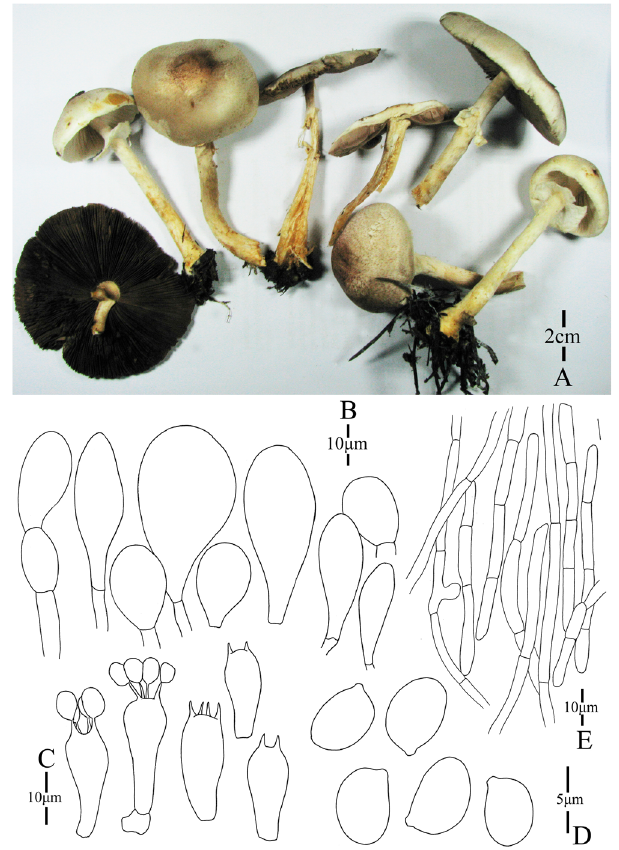
Figure 19. Morphology of Agaricus neimengguensis ( ZRL20151845 , holotype), ( A ): Basidiome in field ( ZRL20151845 ), ( B ): Cheilocysitidia, ( C ): Basidia, ( D ): Basidiospores, and ( E ): Pileipellis